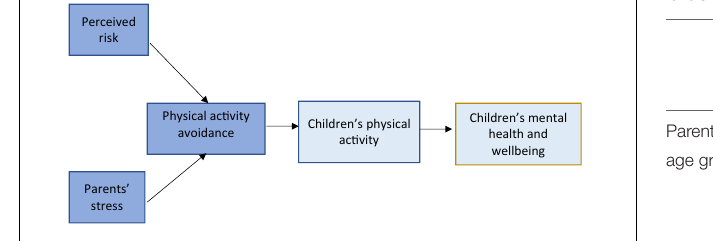
FIGURE 1 | The conceptual research model and the relationship between variables of interest. Dark blue, parents’ related variables; light blue, children’s related